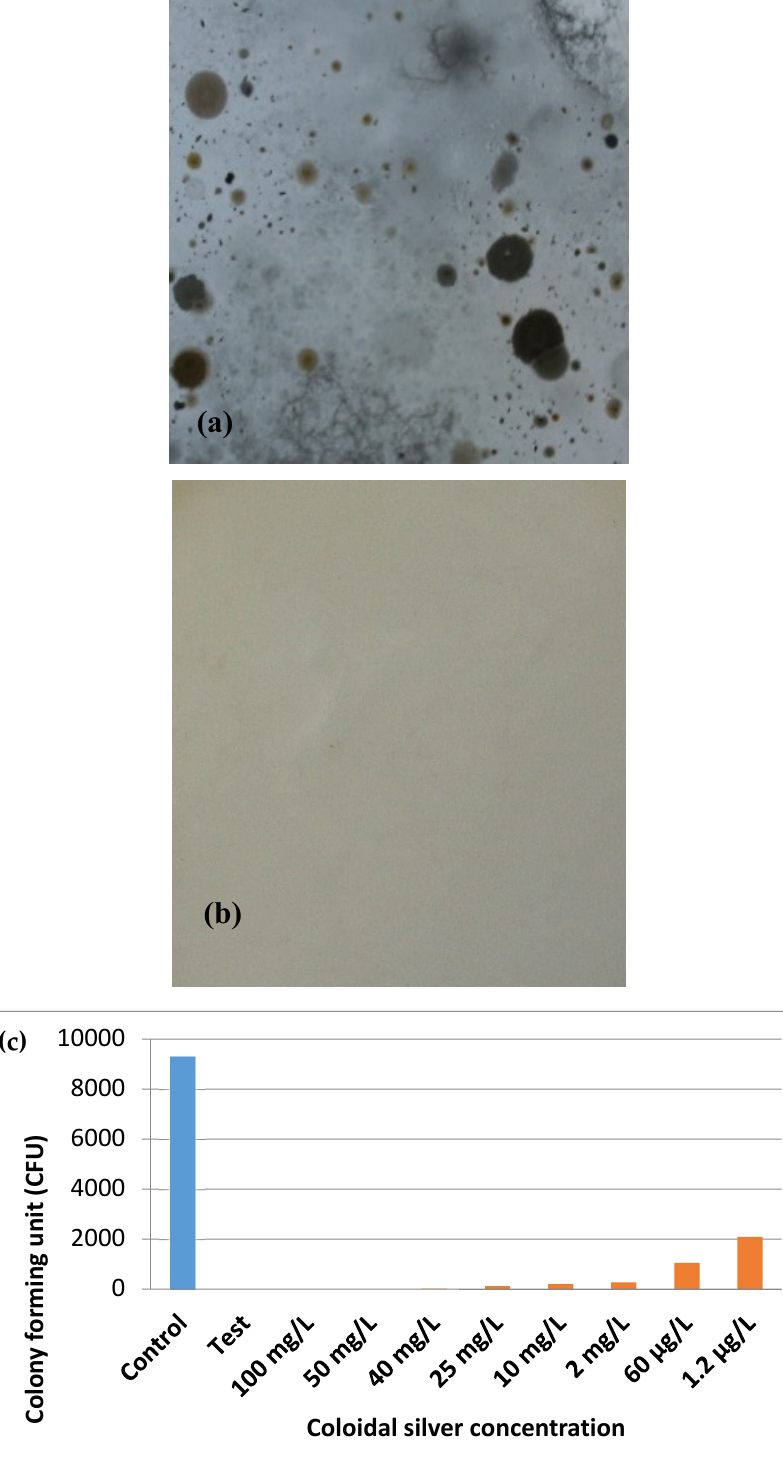
Figure 6. Bacterial inhibition zone image and total colony units. a ) – Control; b ) – 50 mg Ag colloidal/L; c ) – CFU vs colloidal silver concentration.